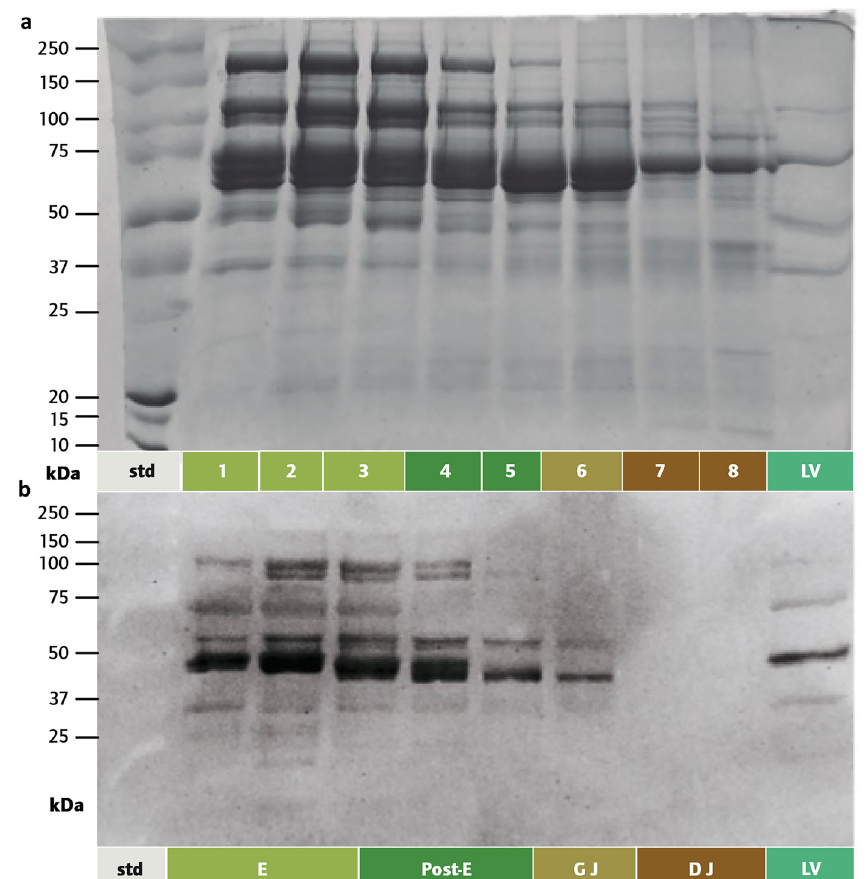
Figure 3. Analysis of soluble proteins during